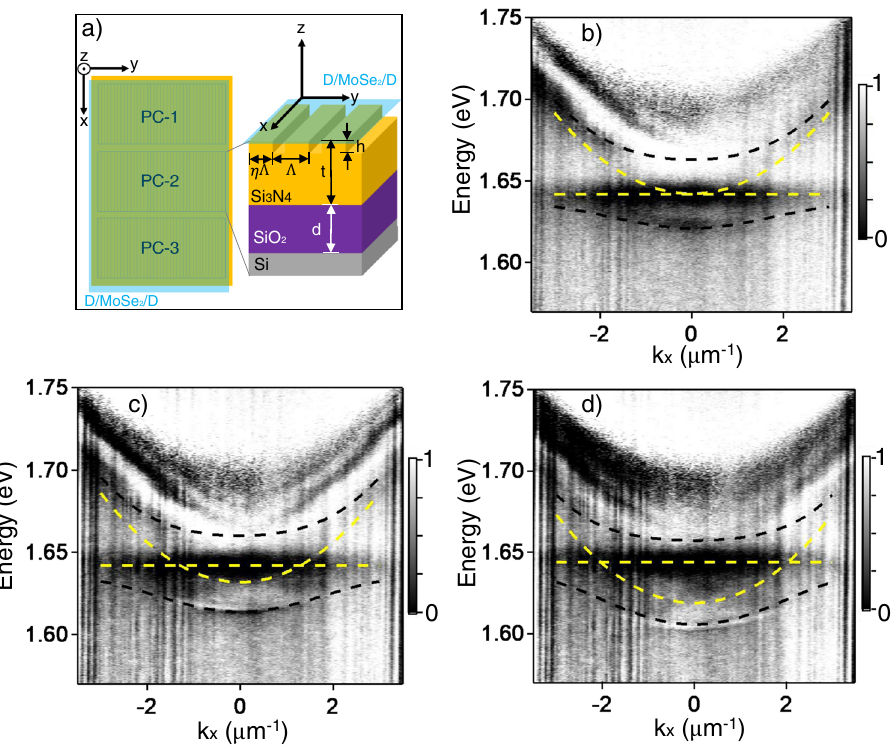
cavity detuning. b – d Angle-resolved RC data of three D/MoSe 2 /D-PC integrated devicesonthesamechip,withthePCmodedetuningof( b )0.1±0.2meV,( c )10±1 meV, and ( d ) 23±1 meV. Black dashed lines mark the lower and upper polariton bands. Yellow dashed lines mark the uncoupled bare exciton and PC